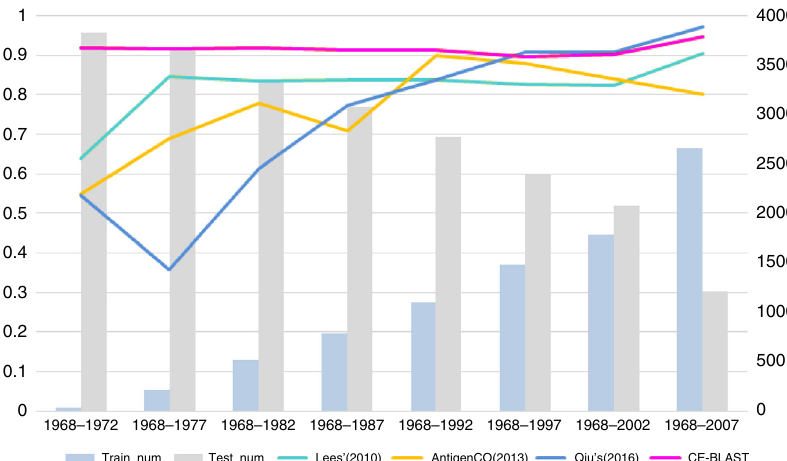
Fig. 2 Performance comparison between CE-BLAST and peers on mutual HI data of 3867 HA pairs of in fl uenza H3. The X axis represents different simulation time points with an increasing window of 5 years. Blue bars show the numbers of training data within the time period, whereas gray bars represent those remaining as testing data, with the corresponding values indicated on the right. Each colored line shows the performance (AUC value) of the computational model, corresponding to the value on the left